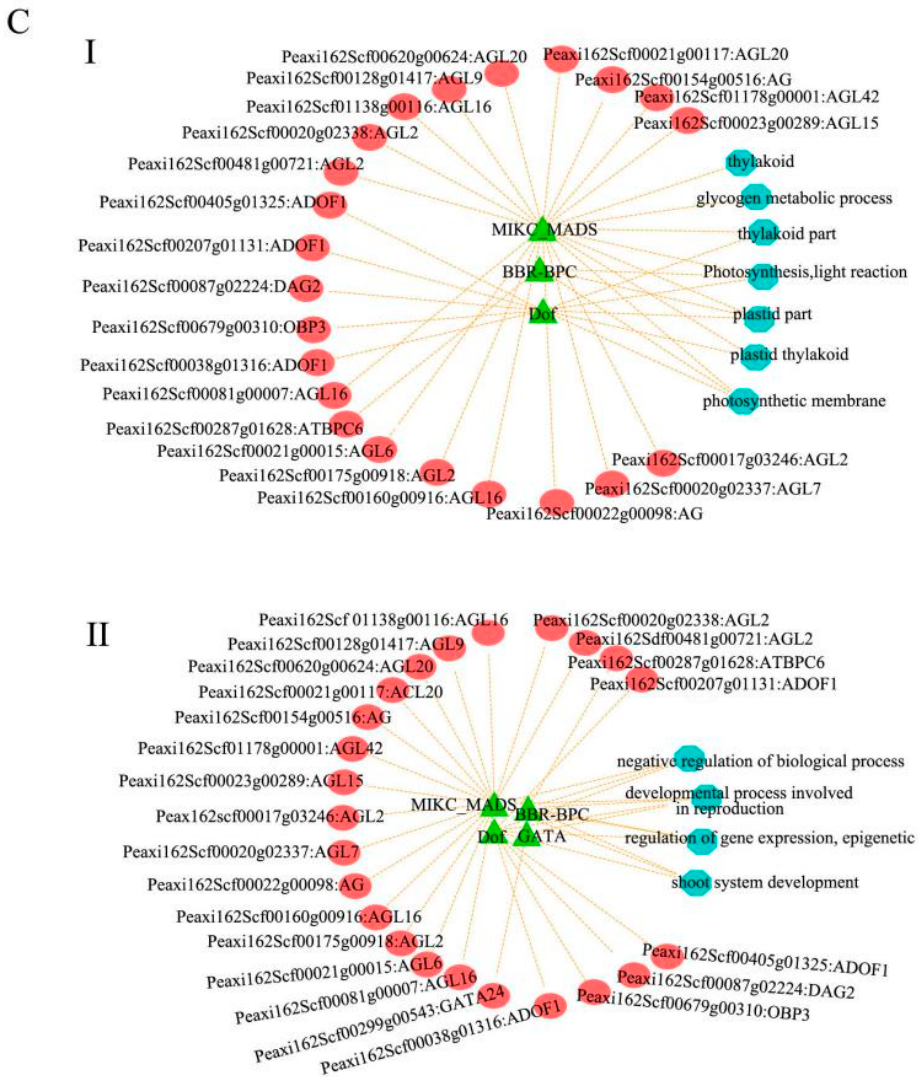
Figure 3. Gene clustering analysis and co-expression network construction. ( A ) Module eigenvector clustering. The six modules were distinguished by different colours assigned by the WGCNA package. The number of genes in each module is indicated on the left. The colour scale represents the strength of the correlation between the modules (from 0 to 1). ( B ) The expression patterns of the co-expressed genes in each module: I , blue module; II , brown module; III , red module; IV , green module; V , yellow module; VI , turquoise module. ( C ) The predicted transcriptional regulatory network associated with blue ( I ) and yel+tur ( II ) modules. The red circles indicate transcription factor (TF) genes and green triangles represent the related TF families. The GO terms of the target genes are indicated by blue hexagons.